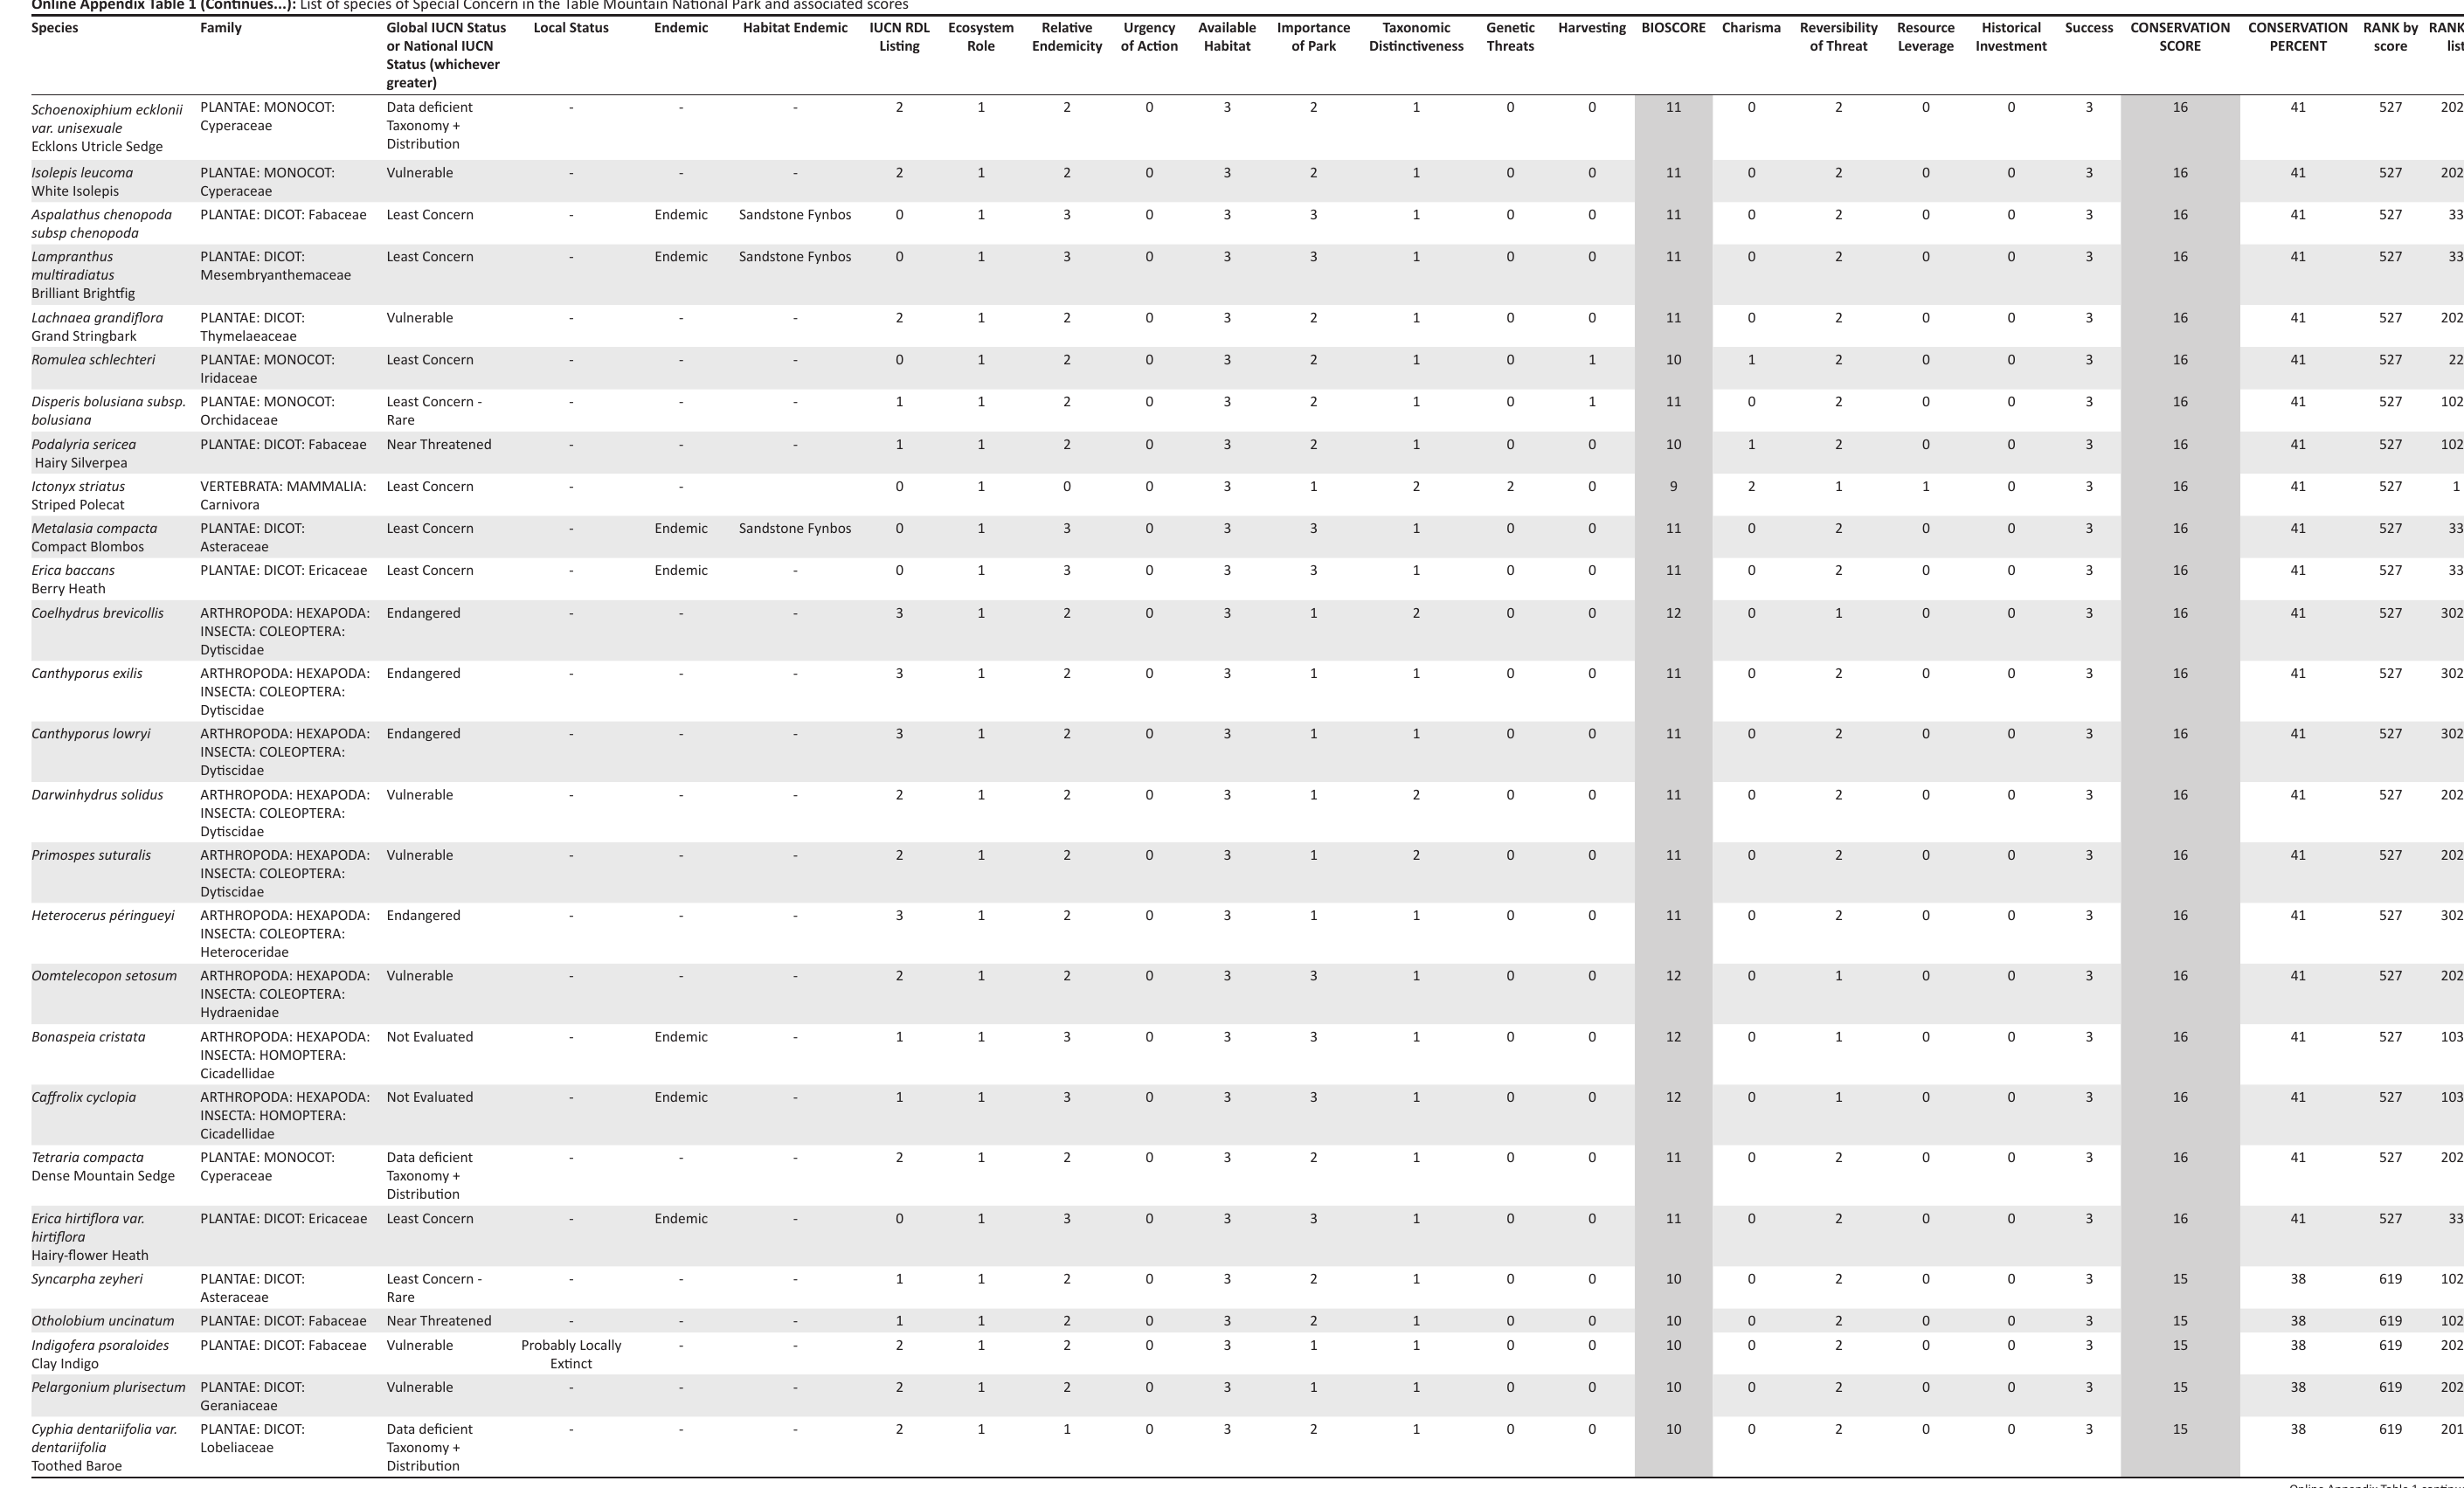
Online Appendix Table 1 (Continues...): List of species of Special Concern in the Table Mountain National Park and associated